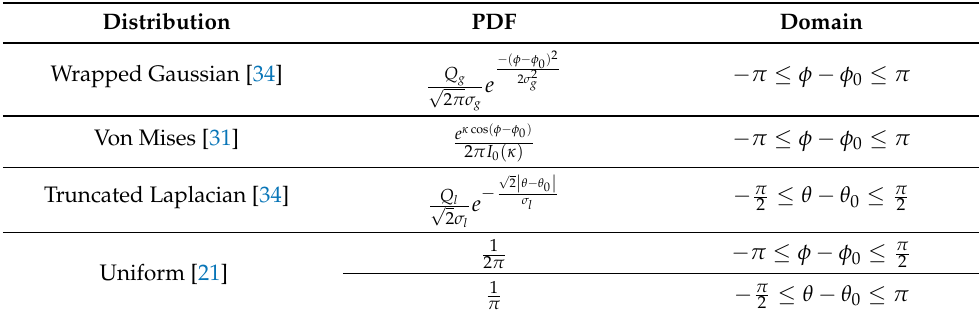
Table 1. PDFs of different angle distributions.